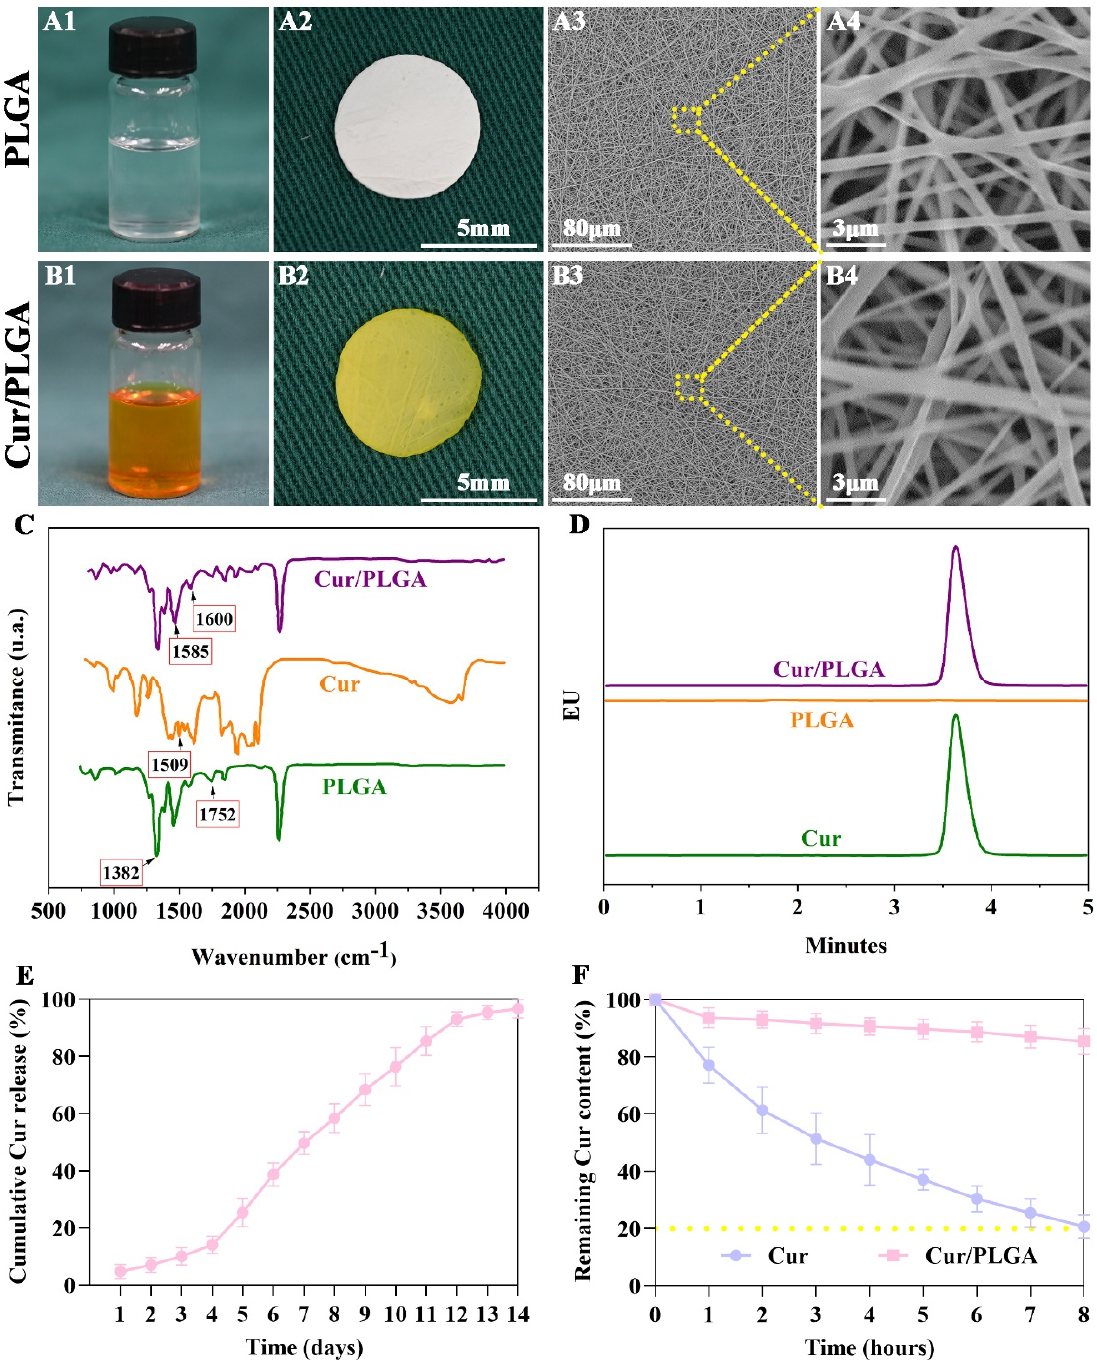
Figure 1. Synthesis and characterization of the poly(lactic − co − glycolic acid) (PLGA) and cur- cumin/PLGA (Cur/PLGA) nanofibrous membranes: Images of spinning solutions of the PLGA ( A1 ) and Cur/PLGA ( B1 ) groups. Images of fabricated nanofibrous membranes of the PLGA ( A2 ) and Cur/PLGA ( B2 ) groups. Scanning electron micrographs of nanofibrous membranes of the PLGA ( A3 , A4 ) and Cur/PLGA ( B3 , B4 ) groups. Fourier − transform infrared (FTIR) spectra ( C ) and high − performance liquid chromatography chromatograms ( D ) of Cur, PLGA, and Cur/PLGA samples. Curve representing the cumulative release of Cur from the Cur/PLGA nanofibrous mem- brane ( E ). Remaining Cur content in the pure Cur and Cur/PLGA groups after incubation with phosphate − buffered saline (PBS) (37 ◦ C, pH 7.4) for 8 h ( F